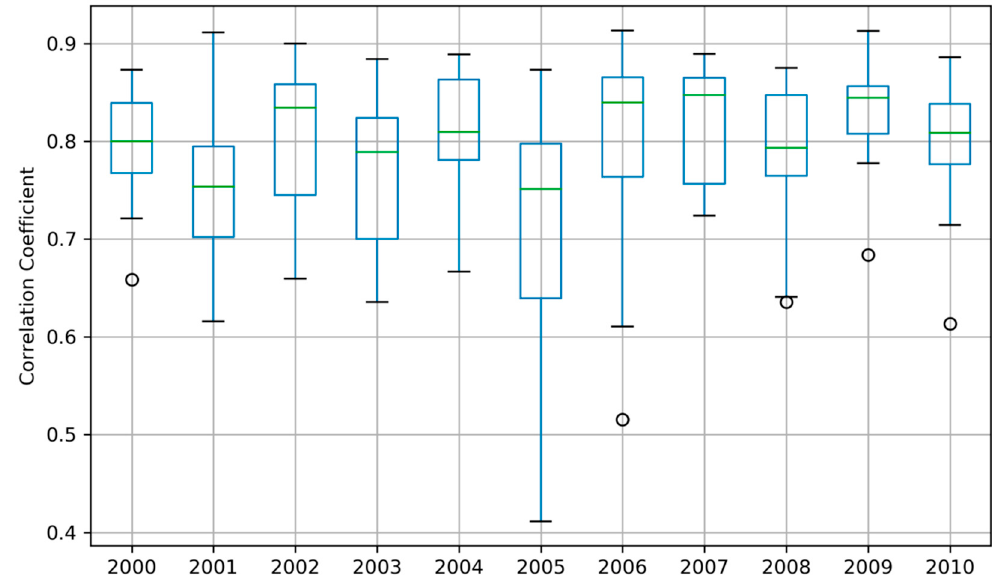
Figure 7. Spatial verification of the ORS fields based on the correlation coefficient. The calculation was done for each of the 15 SYS4 ensemble members (initialized in February) compared to CHIRPS for the entire study region. The statistics used for the visualization of the box and whisker plots are the same as for Figure 6.